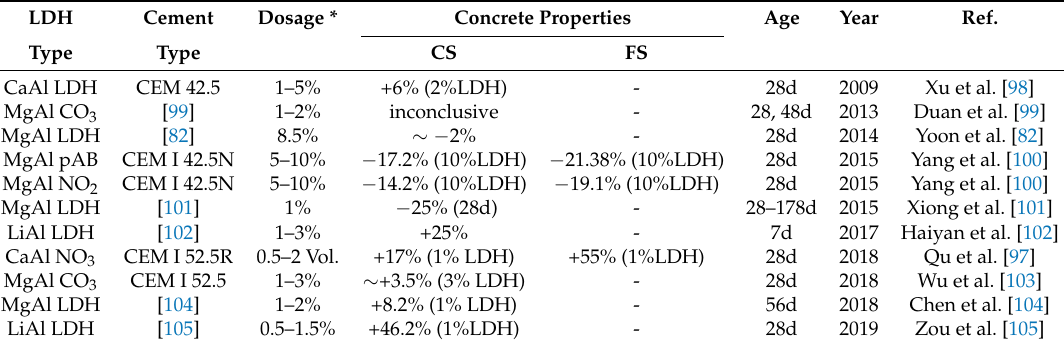
Table 1. Effect of addition of LDH on the mechanical properties of concrete. CS: Compressive strenght; FS: Flexural